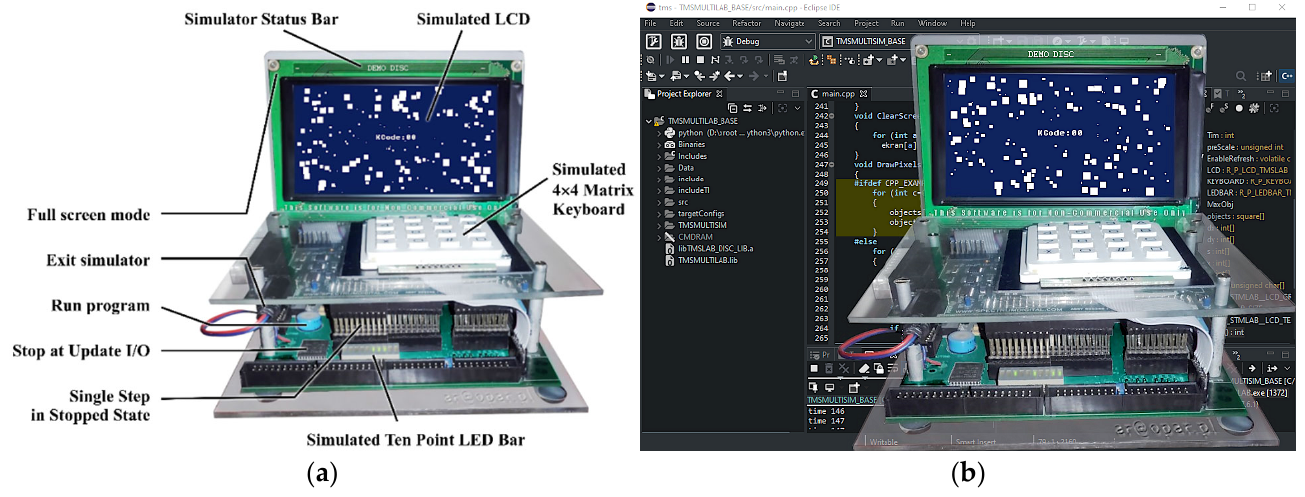
Figure 12. Virtual simulator of the TMSLAB didactical module running a demo program: ( a ) simulator components and GUI; ( b ) simulator running on Microsoft Windows platform under Eclipse IDE control.